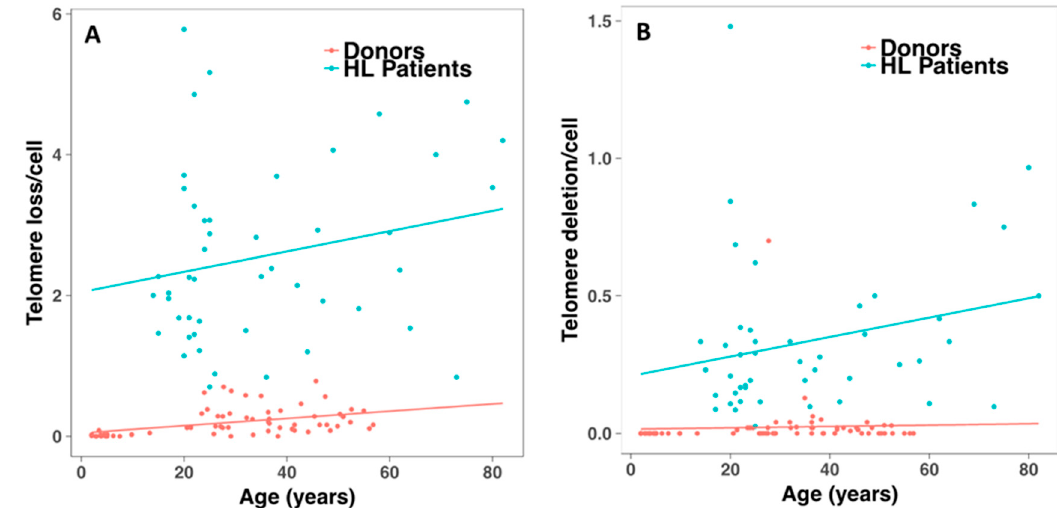
Figure 17. Telomere dysfunction detected in circulating lymphocytes of HL patients. ( A ) Significant difference between the frequencies of telomere loss for HL patients and those detected for healthy donors. ( B ) The same results were observed for telomere deletion. Telomere deletion and telomere loss in lymphocytes of healthy donors are represented by the red circles and in those of HL patients by blue circles, respectively.